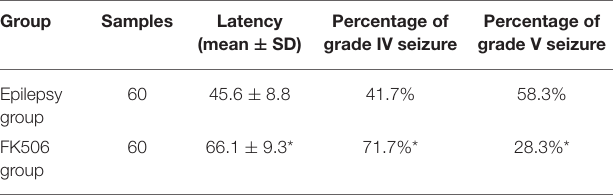
TABLE 1 | The latency of grade IV seizures and percentages of grade IV and above seizures in rats.